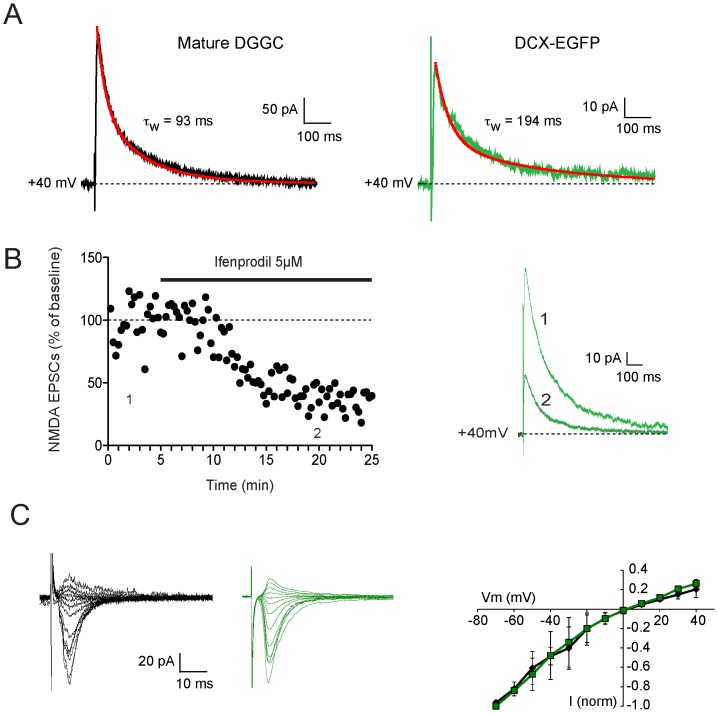
Both Immature and Mature Granule Cells Have Slow NMDA Kinetics and Rectifying AMPA Receptors in Swiss Webster Mice.A. NMDA currents recorded at +40 mV in response to medial perforant path stimulation in a mature granule cell (left) and from and EGFP-positive newborn neurons (right). Recordings were fit with a double exponential equation and the fit is overlaid (red lines). B. The NMDA receptor mediated EPSC in newborn neurons is blocked by ifenprodil. Panel on left shows the normalized NMDA-receptor mediated EPSC amplitude for one cell recorded at +40 mV before and following application of 5 µM ifenprodil. The EPSCs recorded at the indicated time points are superimposed on the right. C. AMPA-receptor mediated synaptic currents recorded over a range of membrane potentials from −80 to +40 mV following blockade of NMDA receptor currents with d-AP5. Currents were normalized to the peak current recorded at −80 mV and plotted against voltage to demonstrate the slight rectification at depolarized potentials in both mature (black traces) and newborn (green traces) granule cells. The peak current-voltage relationship for the two cell types are shown on the right.